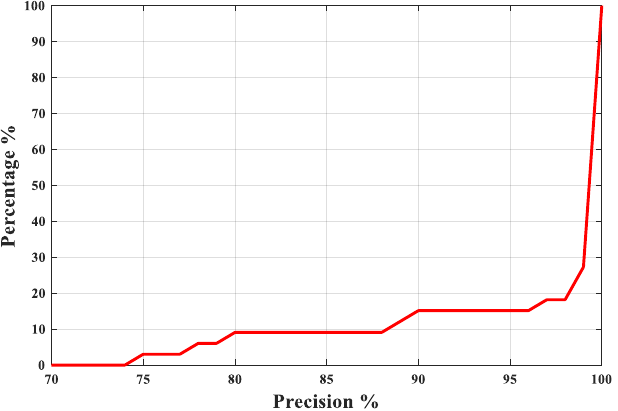
Figure 11. Cumulative distribution function of the